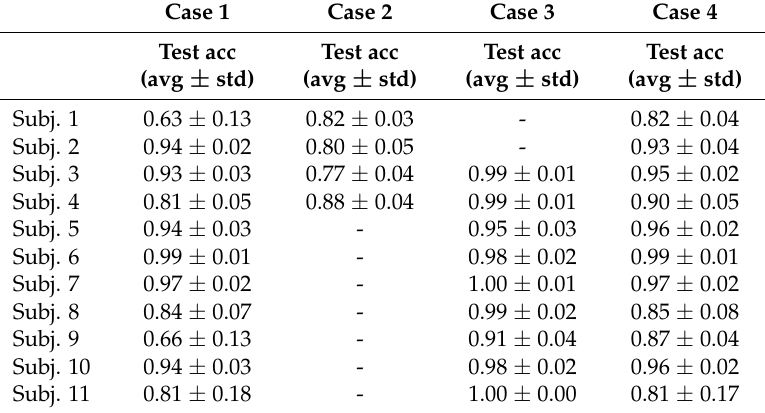
Table 1. MF classification results using a CNN with different sensor configurations. The different case configurations are as follows: Case 1—EMG, temperature, ECG; Case 2—eye tracker; Case 3—EEG; Case 4—all available